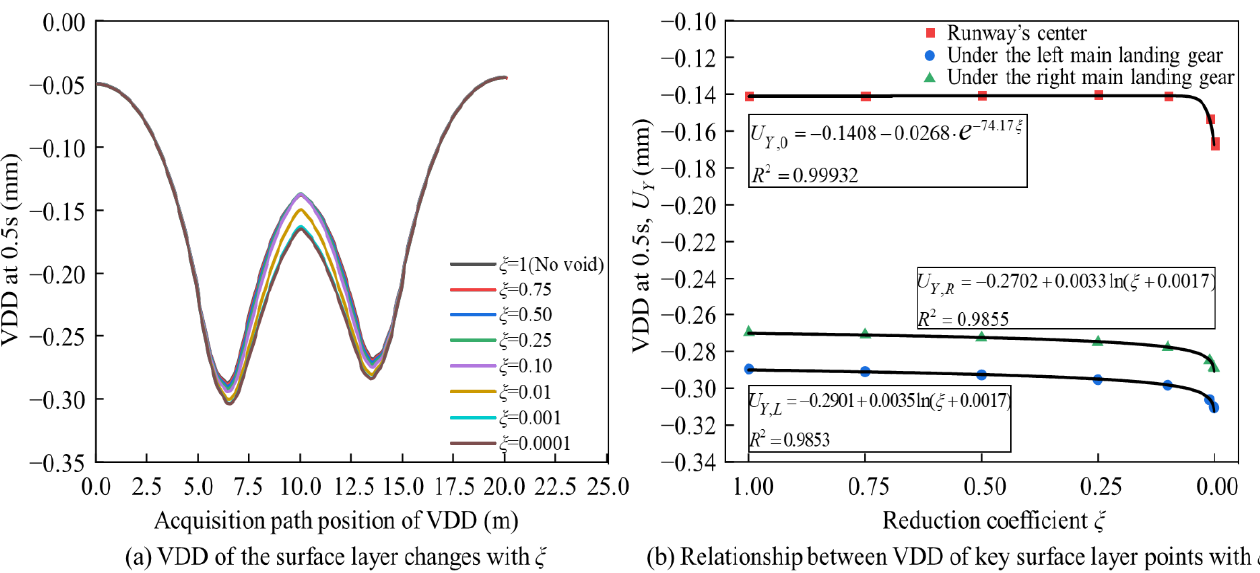
Figure 11. VDD of pavement in case of slight void.